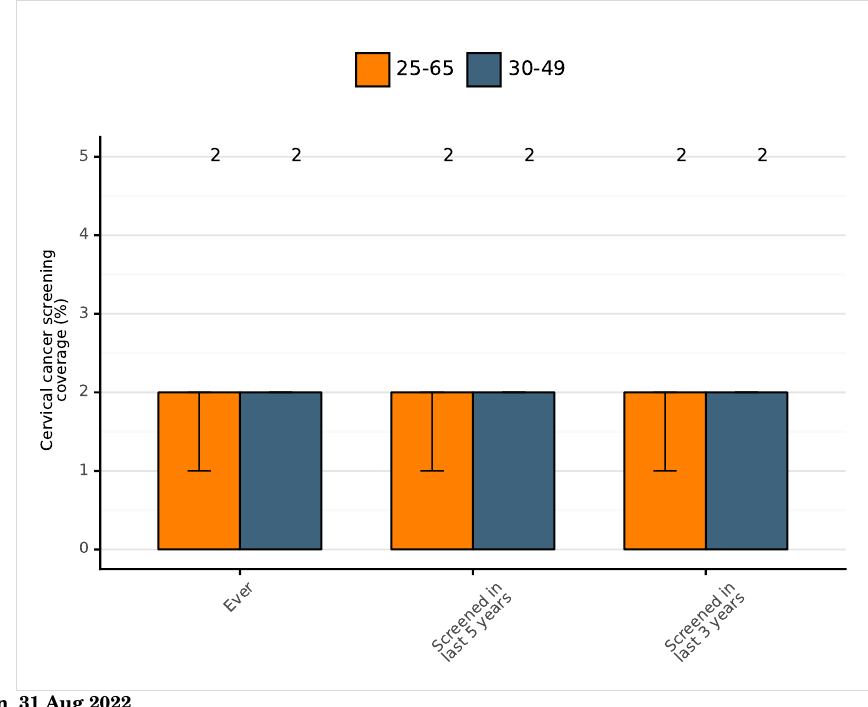
Figure 70: Estimated coverage* of cervical cancer screening in